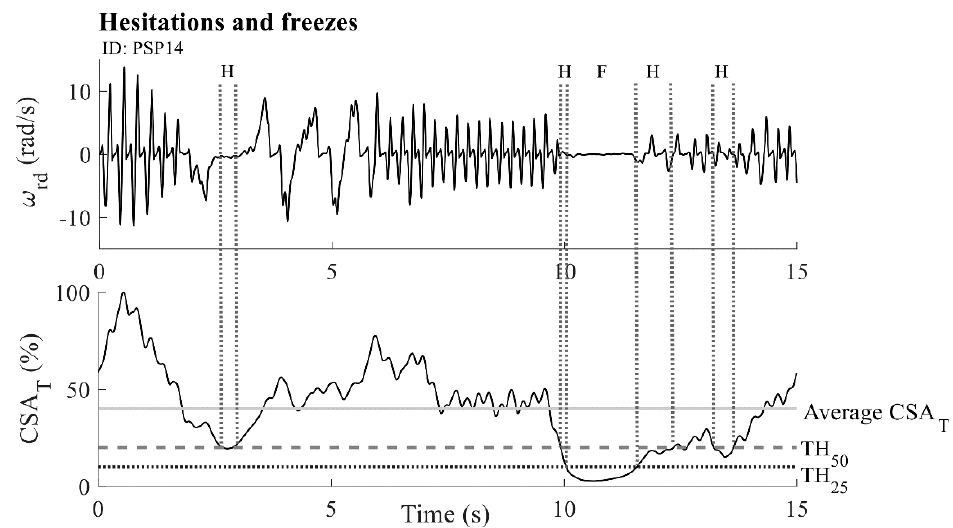
Figure 5. Calculation of hesitations and freezes: angular velocity ω rd (upper panel) and calculated CSA T characteristic (bottom panel). The solid grey horizontal line marks the average CSA T value. The dashed grey horizontal line corresponds to the upper threshold TH 50 = 50% of the CSA T average value. The dotted black horizontal line shows the lower threshold TH 25 = 25% of the CSA T- average value. Similarly, dotted grey vertical lines show areas that are classified as hesitations (an “H” mark) and freezes (an “F” mark). The example is given for one PSP patient (ID: PSP14).